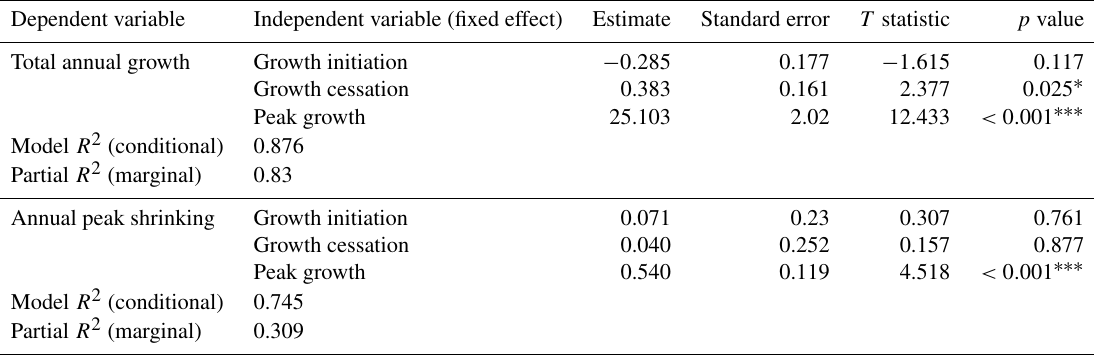
Table 2. Results of linear mixed-effect modeling of total annual growth (measured cumulative stem diameter increment in comparison to the previous year’s maximum stem diameter) and annual peak shrinking (maximum stem water deficit), modeled from growth parameters (growth initiation, growth cessation, and peak growth). Sites (including study region and elevation) entered into the models as random effects. R 2 for the models was calculated using the r.squaredGLMM function from the MuMIn package (Barton,